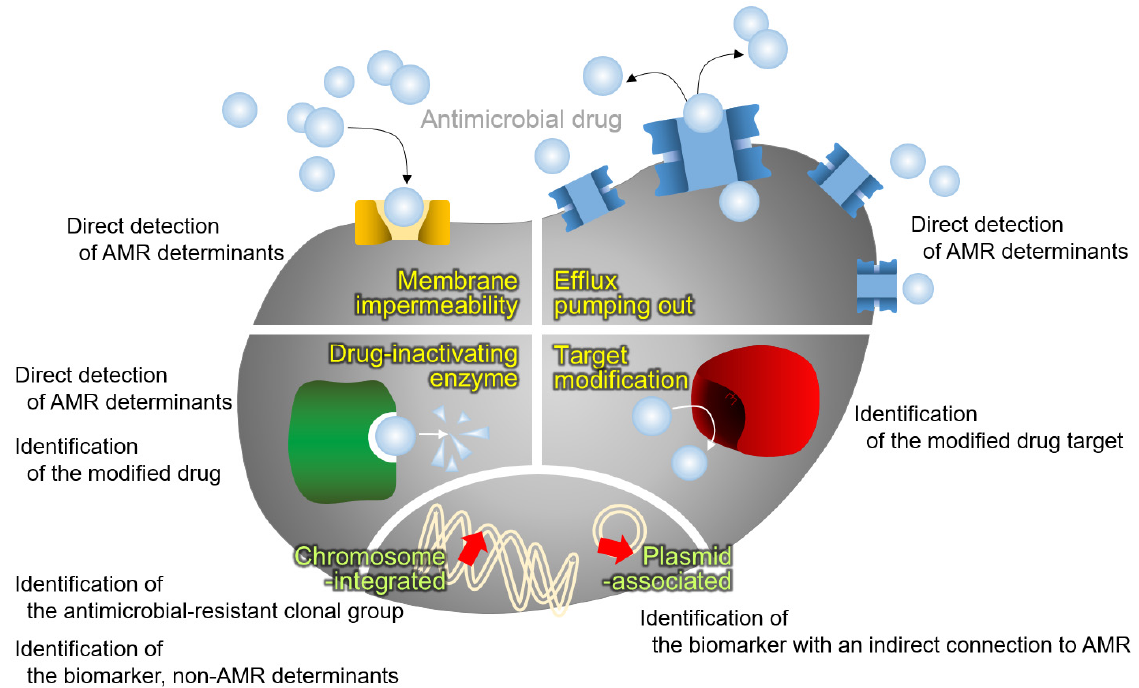
Figure 2. MALDI-TOF MS approaches for AMR detection. Four mechanisms of antimicrobial resistance (in yellow), i.e., membrane impermeability by loss or modification of the outer membrane porin, overproduction of the drug efflux pumping out system, antimicrobial drug modification by the drug-inactivating enzyme, and modification of the drug target, and the location of the genes for AMR (in lime), i.e., integrated in chromosome and located in plasmid, are presented with the relevant approach for AMR diagnostics using the MALDI-TOF MS.